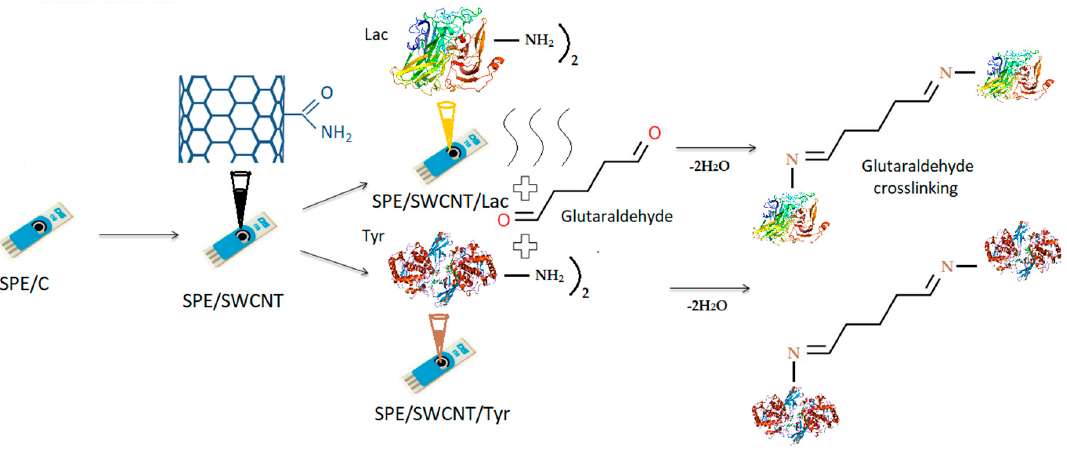
Figure 11. Preparation process of the tyrosinase and laccase biosensors based on a carbon-based screen-printed electrode. screen-printed